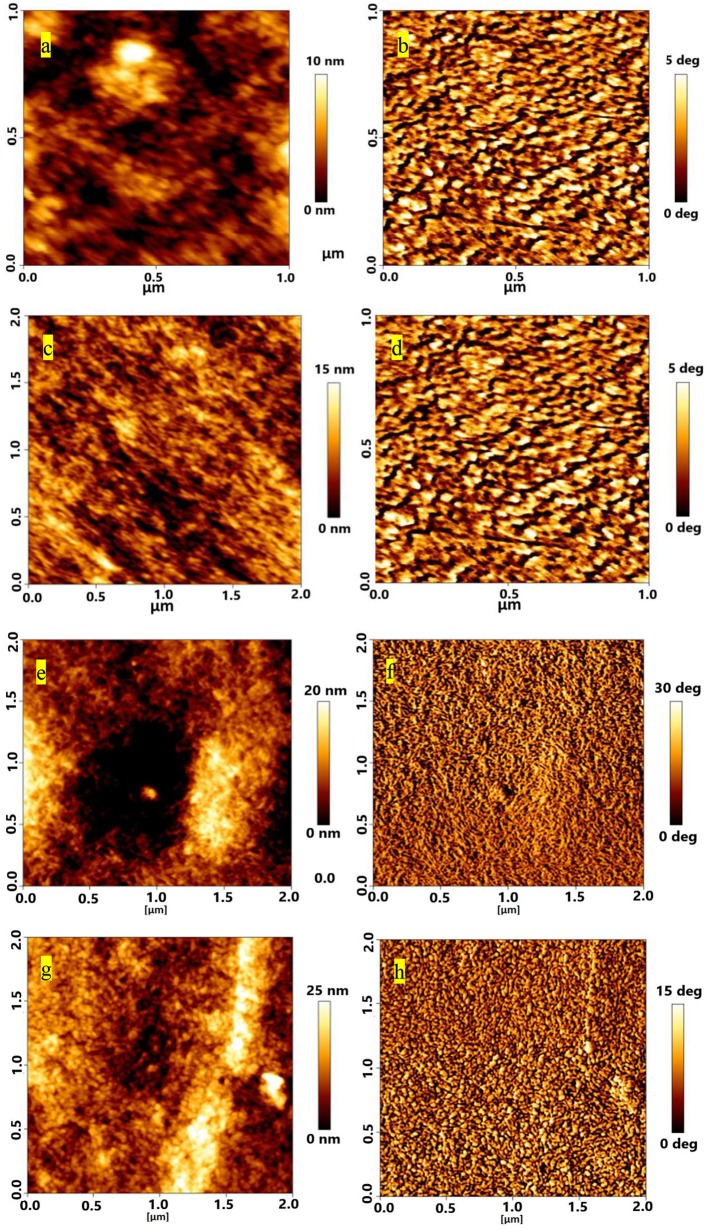
AFM topography images of different loading of DMSO2 in PEDOT:PSS films for (a) pristine (c) 1% (e) 3% and (g) 5%; corresponding phase images are shown on right panels (b,d,f,h).